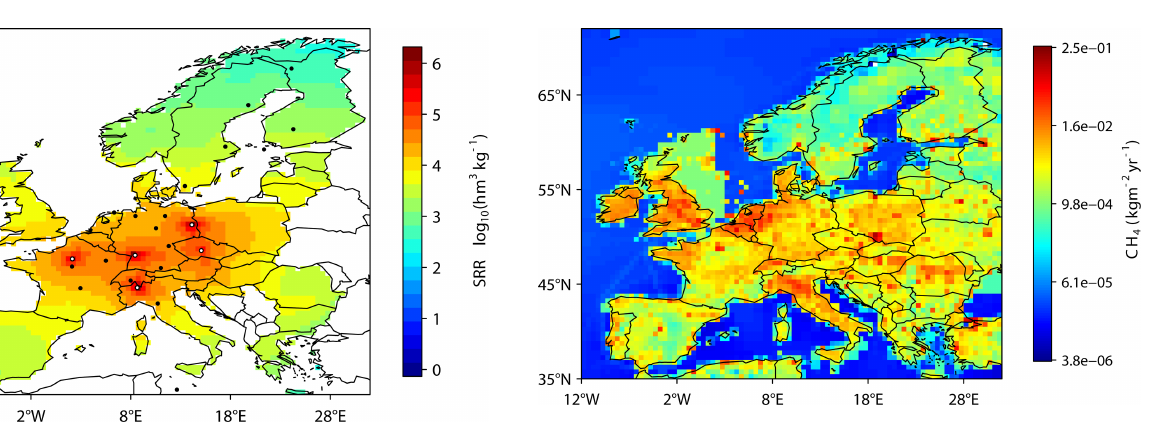
Figure 1. Map of the total mean SRRs for optimal sites for scenar- ios 1 and 2. Since only the EU27 + 3 emissions are constrained, the SRRs are also only shown for EU27 + 3. The locations of the opti- mal sites are indicated by the white points (i.e. IPR, SAC, KIT, LIN, and KRE), and the locations of the unselected sites are indicated by the black points.